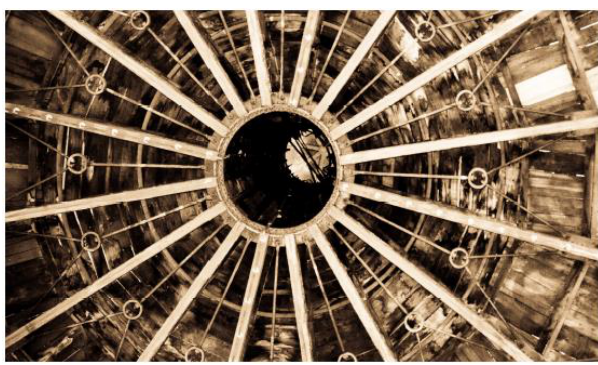
Figure 5. The internal structure of the